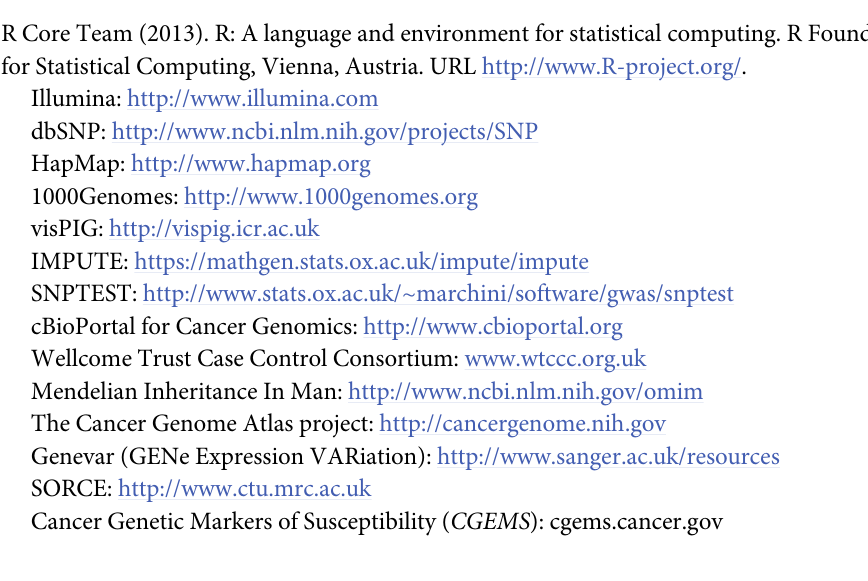
S1 Dataset. UK & NCI association test results with meta-analysis results. Tab-delimited ASCII text file with one header row. S1 Fig. Q-Q plots of Cochran-Armitage trend test statistics for association based on meta- analysis of UK-GWAS and NCI-GWAS pre-imputation (a-b); post-imputation (e-h) and rare SNPs post-imputation (i-l). The identity line is indicated as a blue dashed line. S2 Fig. first two principal components of the UK and NCI datasets, as used for removing samples based on ancestry during quality control. Case and control samples are indicated as grey and black crosses, with the HapMap reference populations shown as bold coloured discs. S3 Fig. GWAS data quality control. Details are provided of samples, SNPs and quality control (QC) used in each GWAS. S1 Table. Evidence for association at previously reported RCC susceptibility loci. At each locus values are given for the previously reported SNPs and the lead SNP in this study.